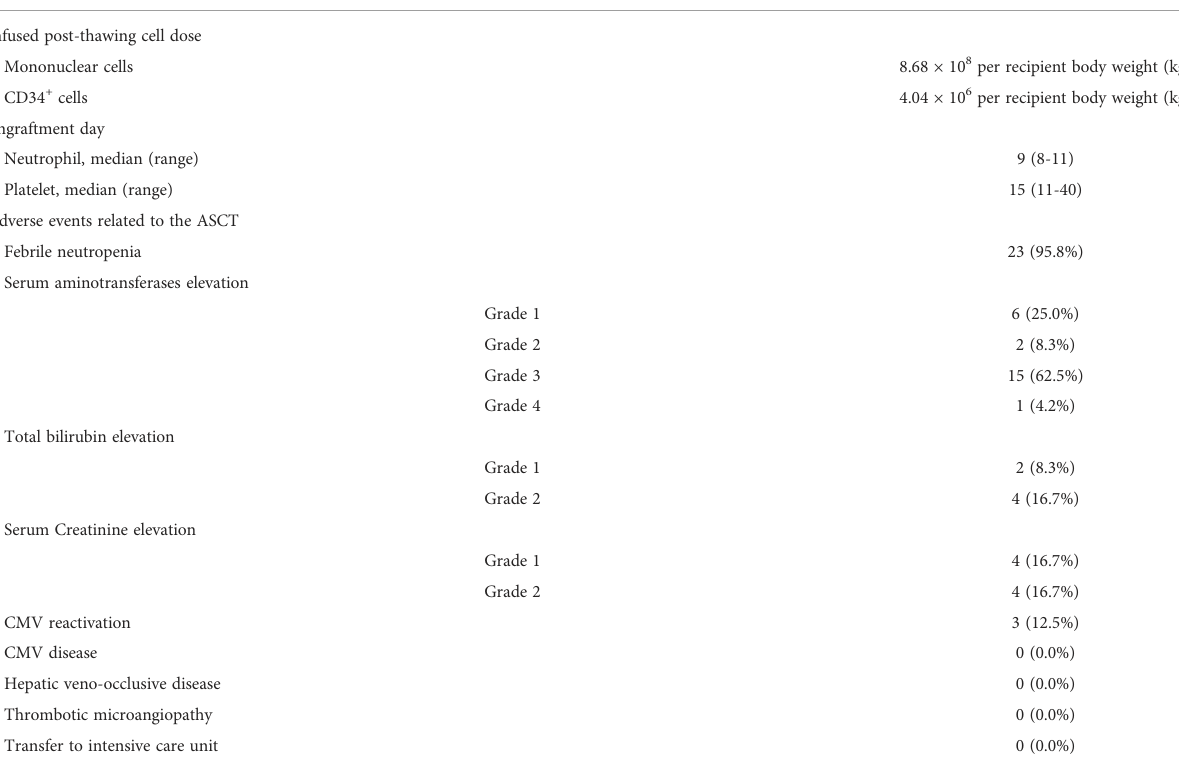
TABLE 4 Stem cell dose, engraftment and adverse events in the PR-HDC